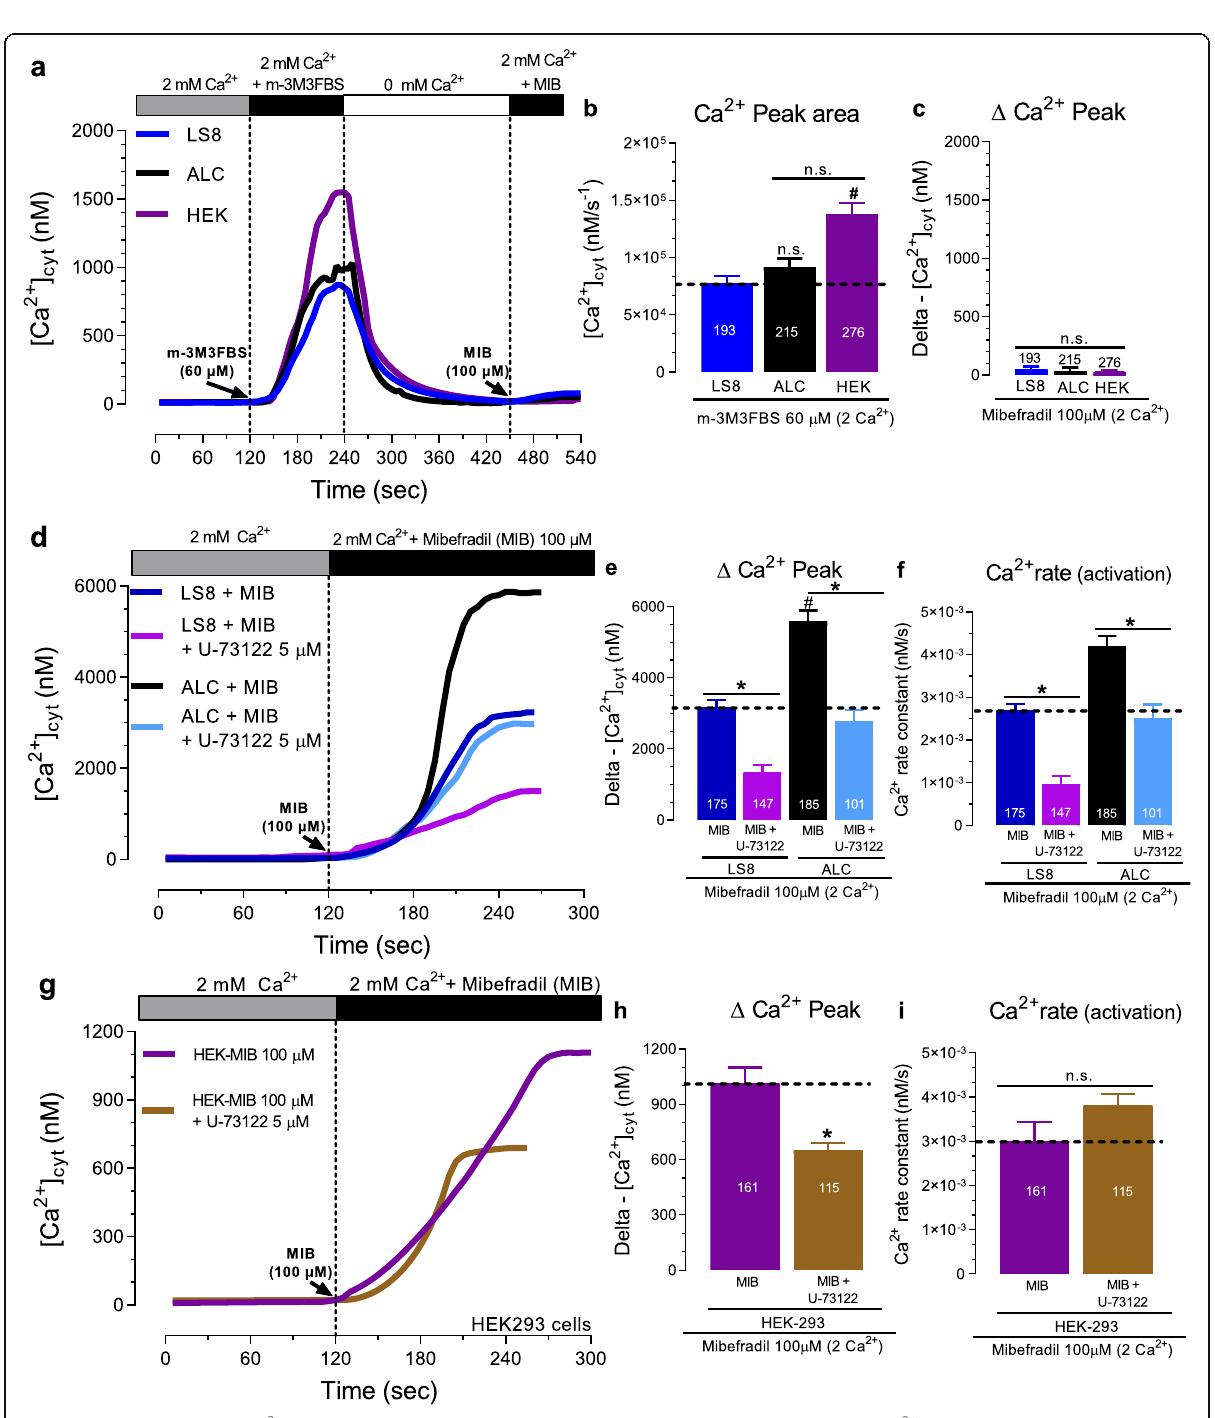
Fig. 4 Mibefradil-mediated [Ca 2+ ] cyt increase is dependent on PLC pathway activation. a Original traces of [Ca 2+ ] cyt transients in LS8, ALC, and HEK-293 cells stimulated with the PLC activator m-3M3FBS (60 μ M), followed by addition of mibefradil (100 μ M) in Ringer ’ s solution containing 2 mM Ca 2+ . b Quantification of the Δ Ca 2+ peak area of under m-3M3FBS stimulation. c Quantification of the Δ Ca 2+ peak under mibefradil stimulation. d Original traces of [Ca 2+ ] cyt transients in LS8 and ALC cells stimulated with mibefradil (100 μ M) in the presence or absence of the PLC inhibitor, U73122 (5 μ M). d Quantification of the Δ Ca 2+ peak. f Quantification of the Ca 2+ influx rate. g-i Same as d-f but in HEK-293 cells. Data represent the mean ± SEM of ≥ 101 cells from 3 independent experiments. Data were analyzed by one-way ANOVA followed by Tukey ’ s multiple comparison post-hoc test. # P < 0.05 vs. LS8 group; * P < 0.05 vs. their respective MIB-100 μ M group; n.s.,